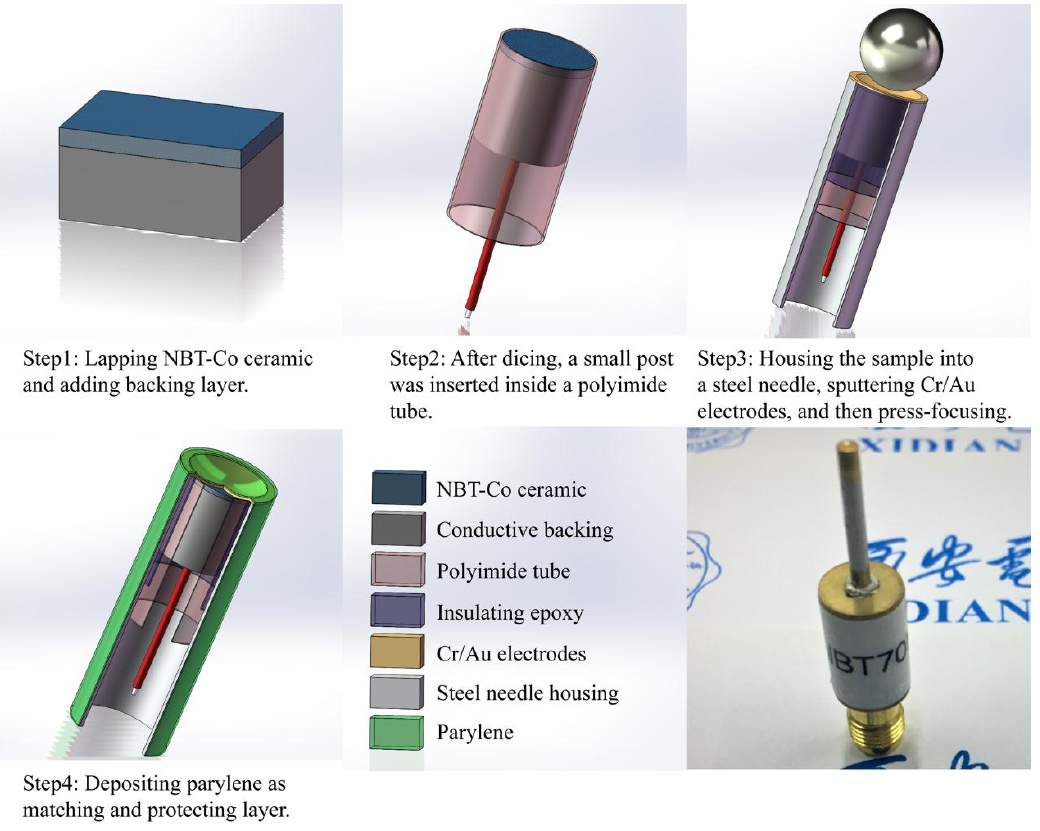
Figure 4. The schematic diagram and photograph of the Co-doped Na 0.5 Bi 4.5 Ti 4 O 15 (NBT-Co) needle transducer.